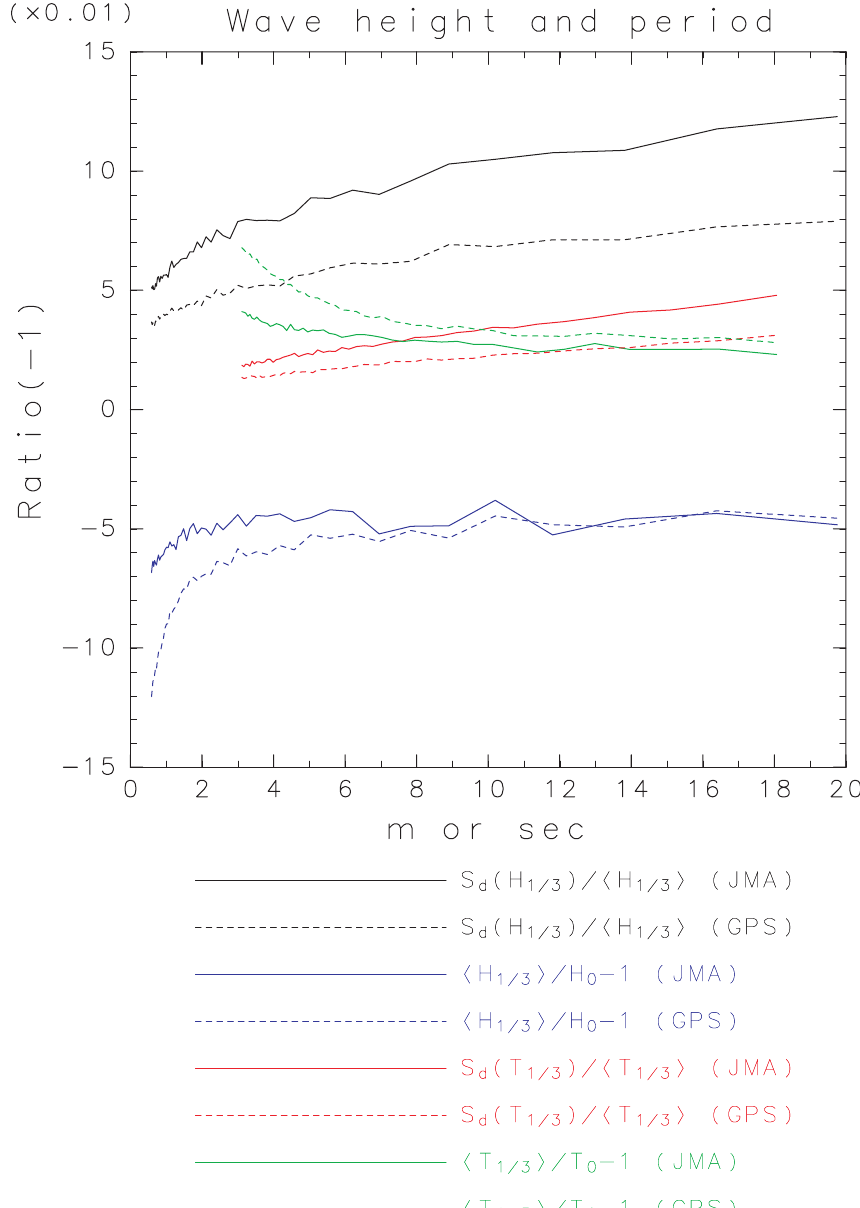
) simulated H 1/3 (cid:104) (cid:105) / H 0 1 ( H 0 = 4 M 1/2 ). Red: Same H 1/3 0 (cid:104) (cid:105) − ). Green: Simulated values of T 1/3 (cid:104) (cid:105)